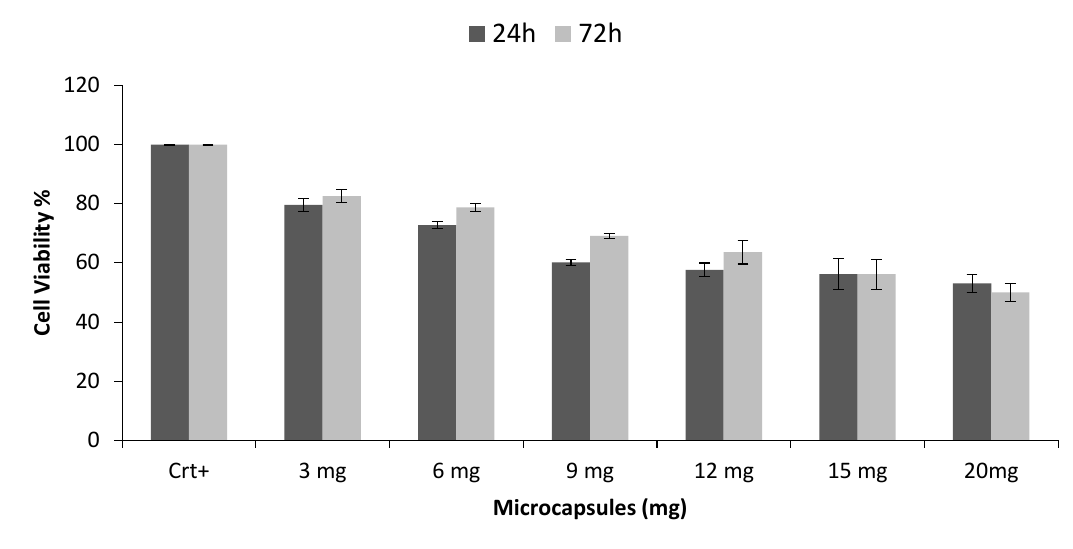
Figure 6. Results of cell viability % evaluated incubating increasing amounts of PMMA microcapsules with 10,000 human fibroblasts 5th passage for 24 h and 72 h.